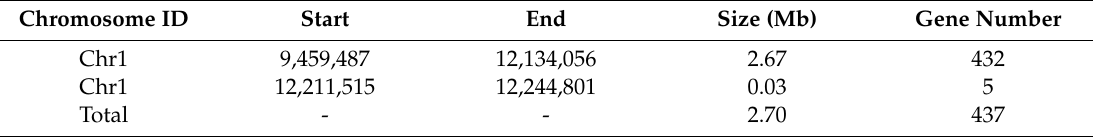
Table 2. Results of associated region by